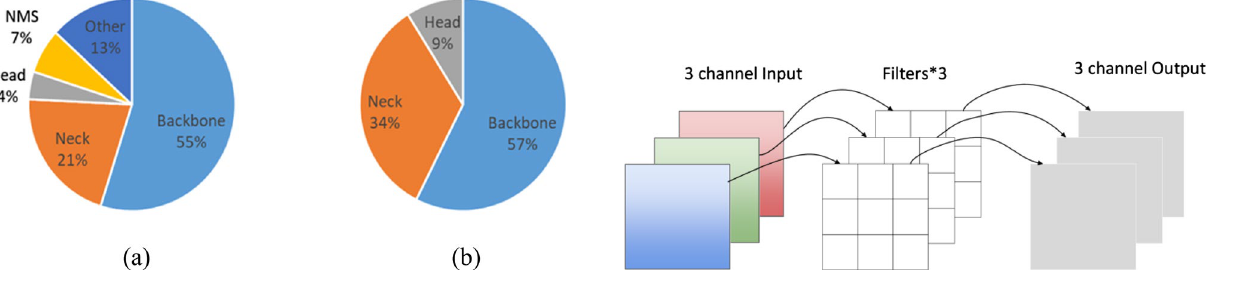
Fig. 1 Proportion of inference time and GFLOPS Fig. 2 Depthwise separable